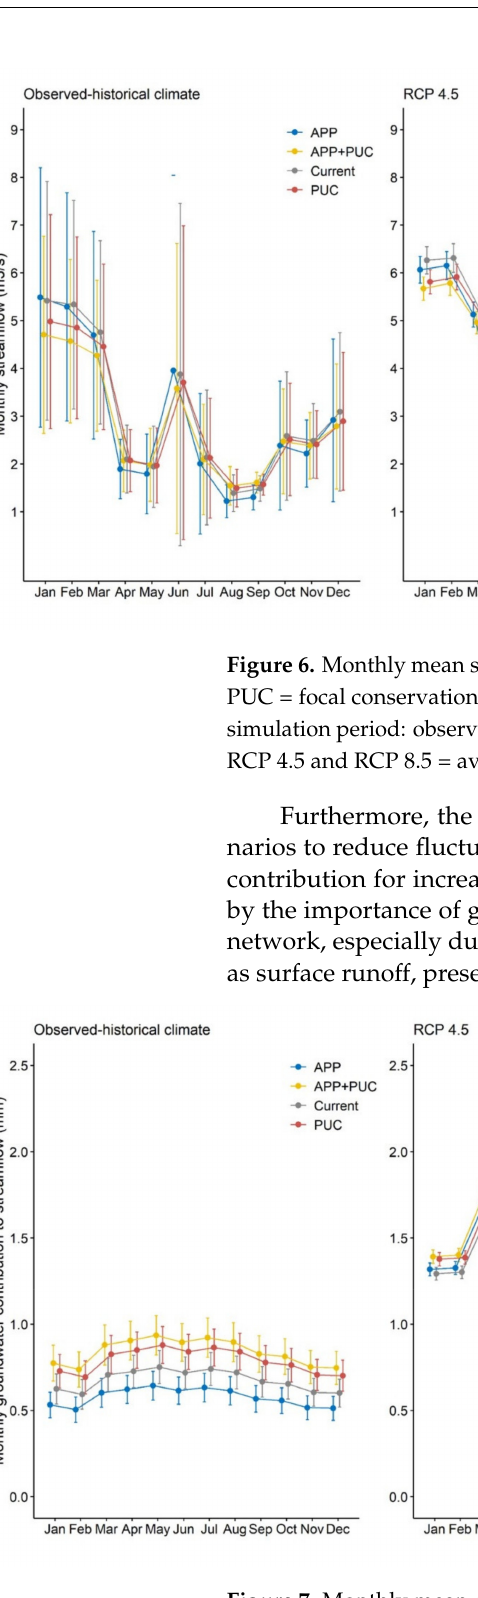
Figure 7. Monthly mean groundwater for each LULC scenario (i.e., Current; APP = riparian restora- tion; PUC = focal conservation; APP + PUC = combined solution) in each climate condition for the entire simulation period: observed historical = average for each month of the year for the years 2012 to 2019; RCP 4.5 and RCP 8.5 = average for each month of the year for the years 2020 to